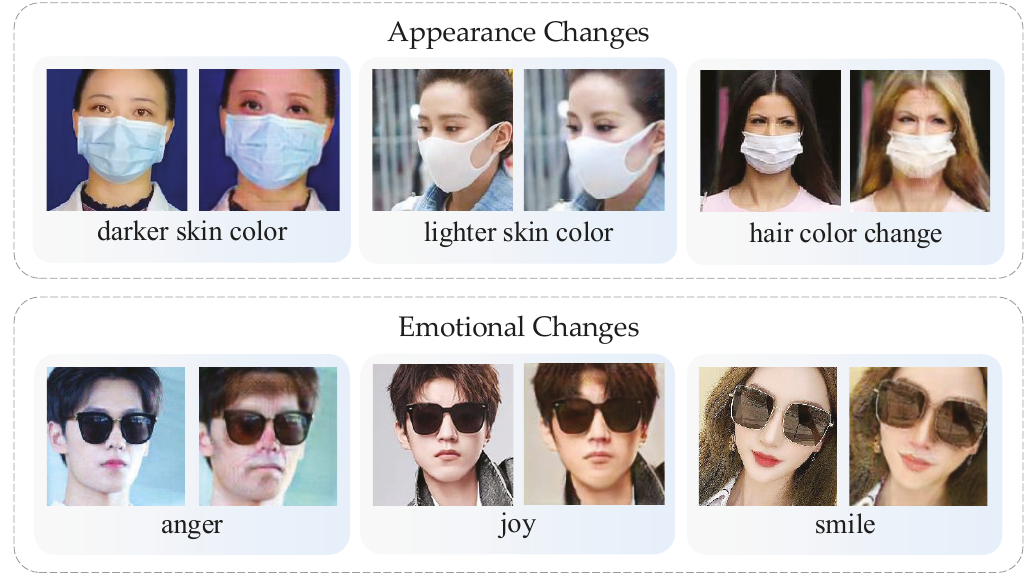
Figure 3. The example of GAN-generated images in FOFDTD.